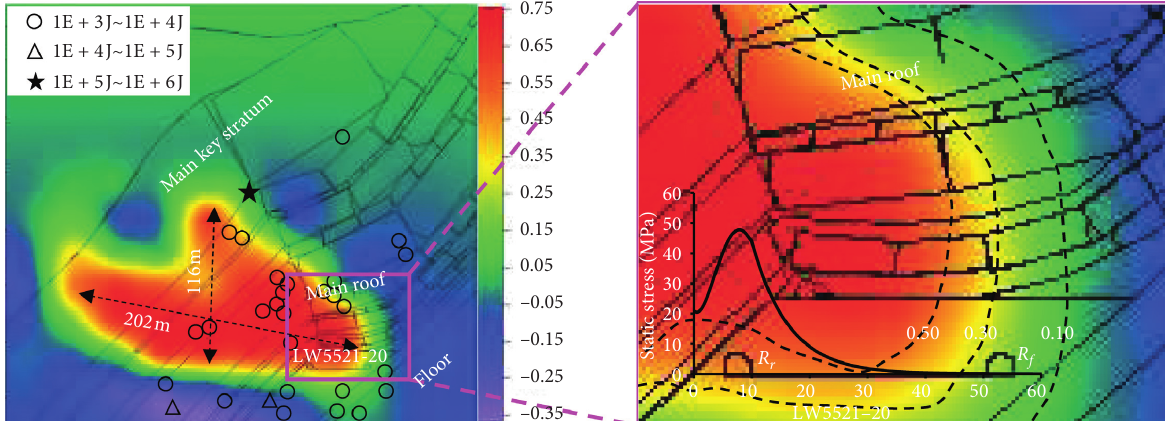
Figure 10: Tomography results between 1 and 30 June, 2016, in LW5521-20.